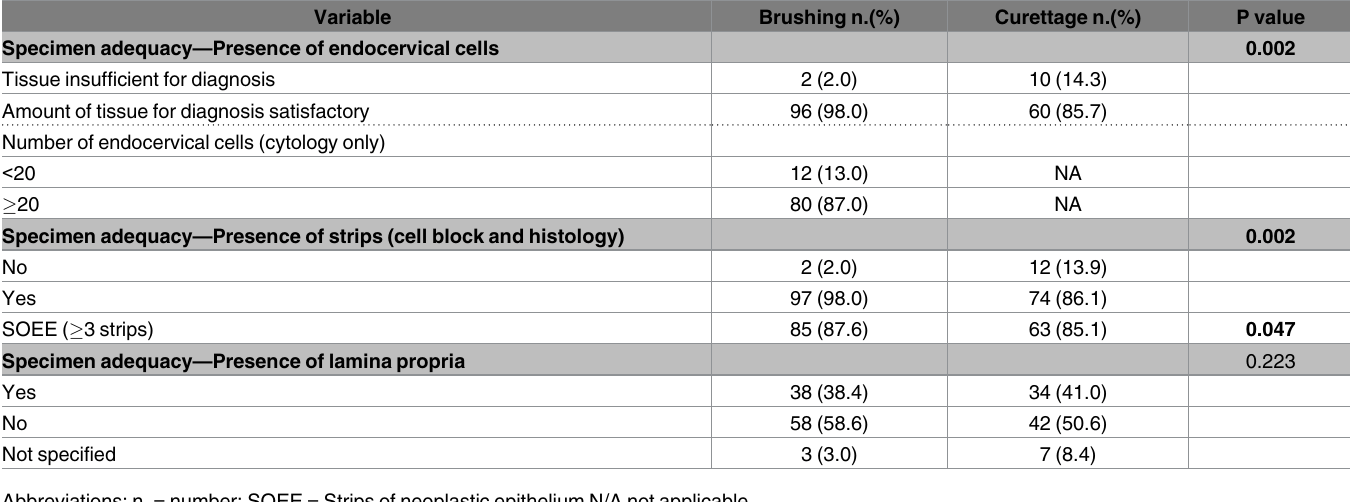
Table 4. Specimen adequacy by study group.